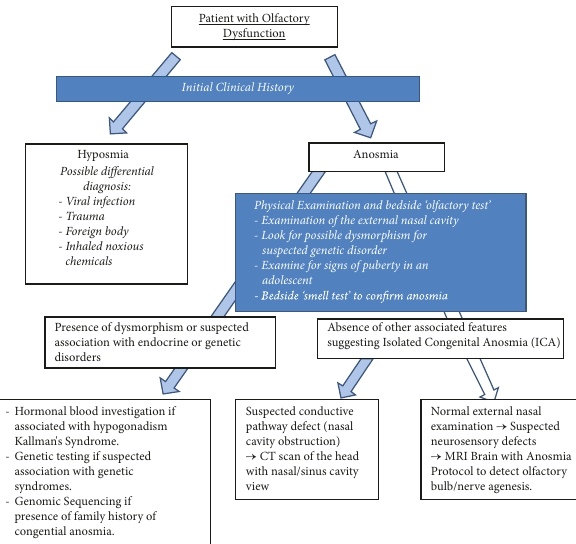
Figure 6: Suggested workflow for paediatric patient with olfactory